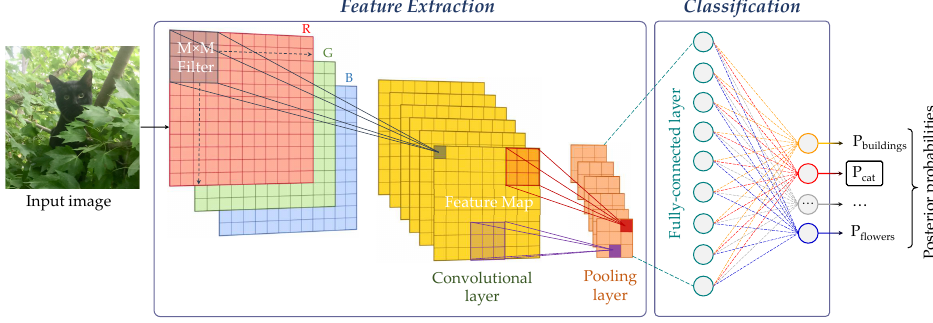
Figure 16. Sample architecture of a convolutional neural